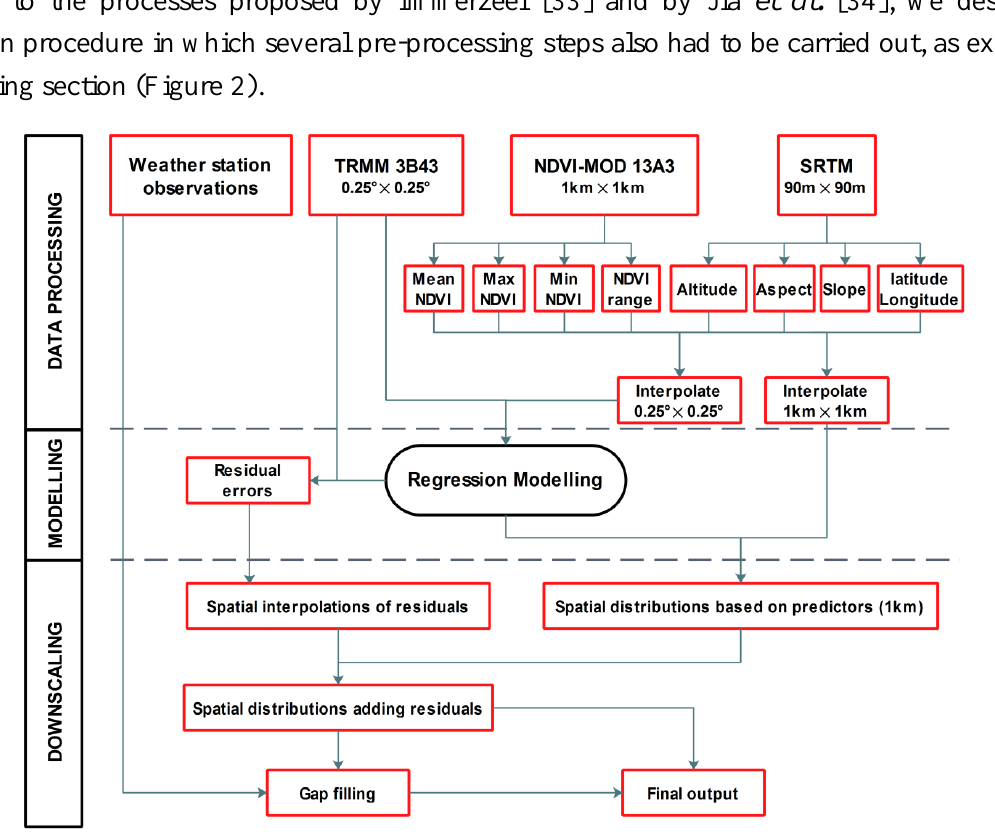
Figure 2. Flow chart of the downscaling algorithm used in the